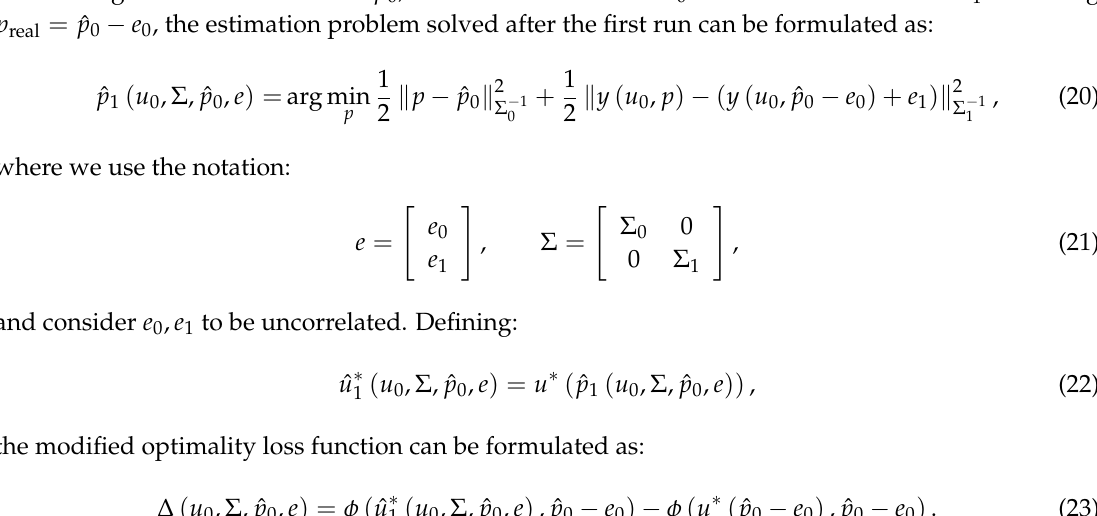
Figure 2. Comparison of the performance resulting from using the nominal input u 0 = u ∗ ( ˆ p 0 ) and the one resulting from (18) or (19) on the proposed example. The displayed cost is calculated according to (10) and reads as E e using (18), which delivers a better expected performance than using the nominal input. The right graph displays the cost resulting from using (19), where p real ≈ ˆ p 0 is used. In this example, this approximation is detrimental to the performance of Problem (10), resulting in a worse performance than the nominal